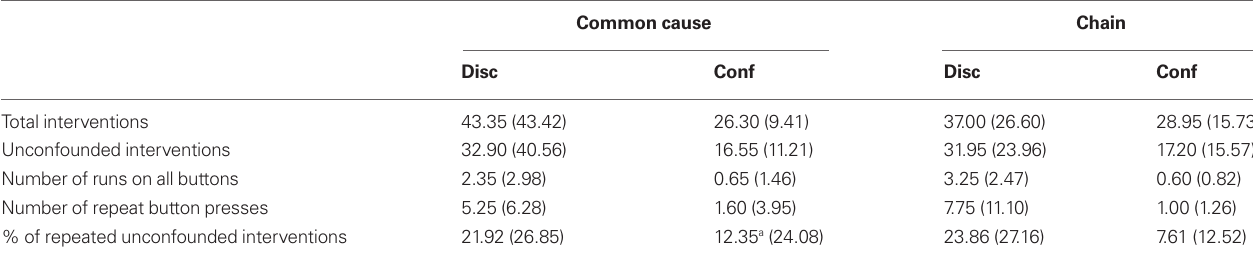
Table 3 | Summary of children’s interventions in the discovery and confirmation